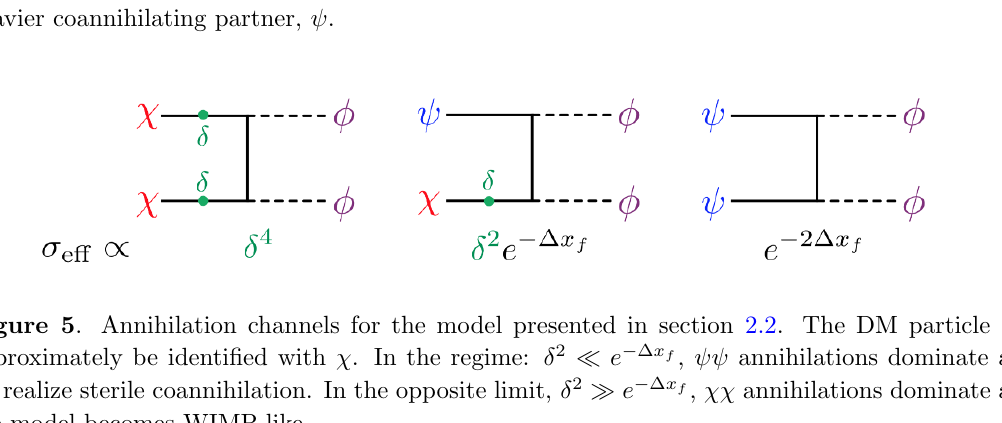
Figure 4 . Schematic representation of the model described in section 2.2. From left to right: the mass spectrum, main annihilation channel, and strength of the mixing between DM, (cid:31) , and its heavier coannihilating partner, .